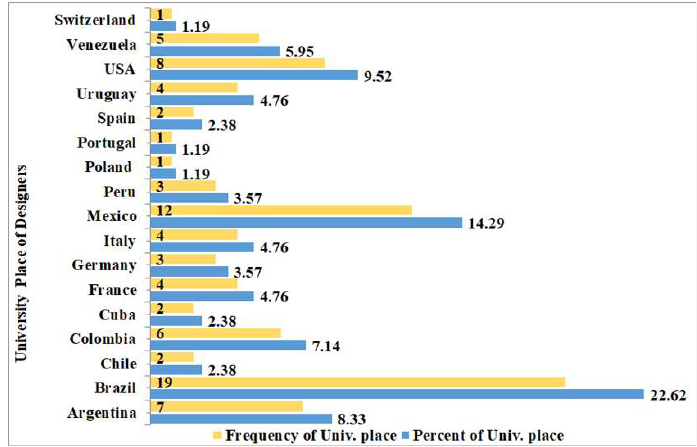
Figure 3. Universities of graduation of the designers.